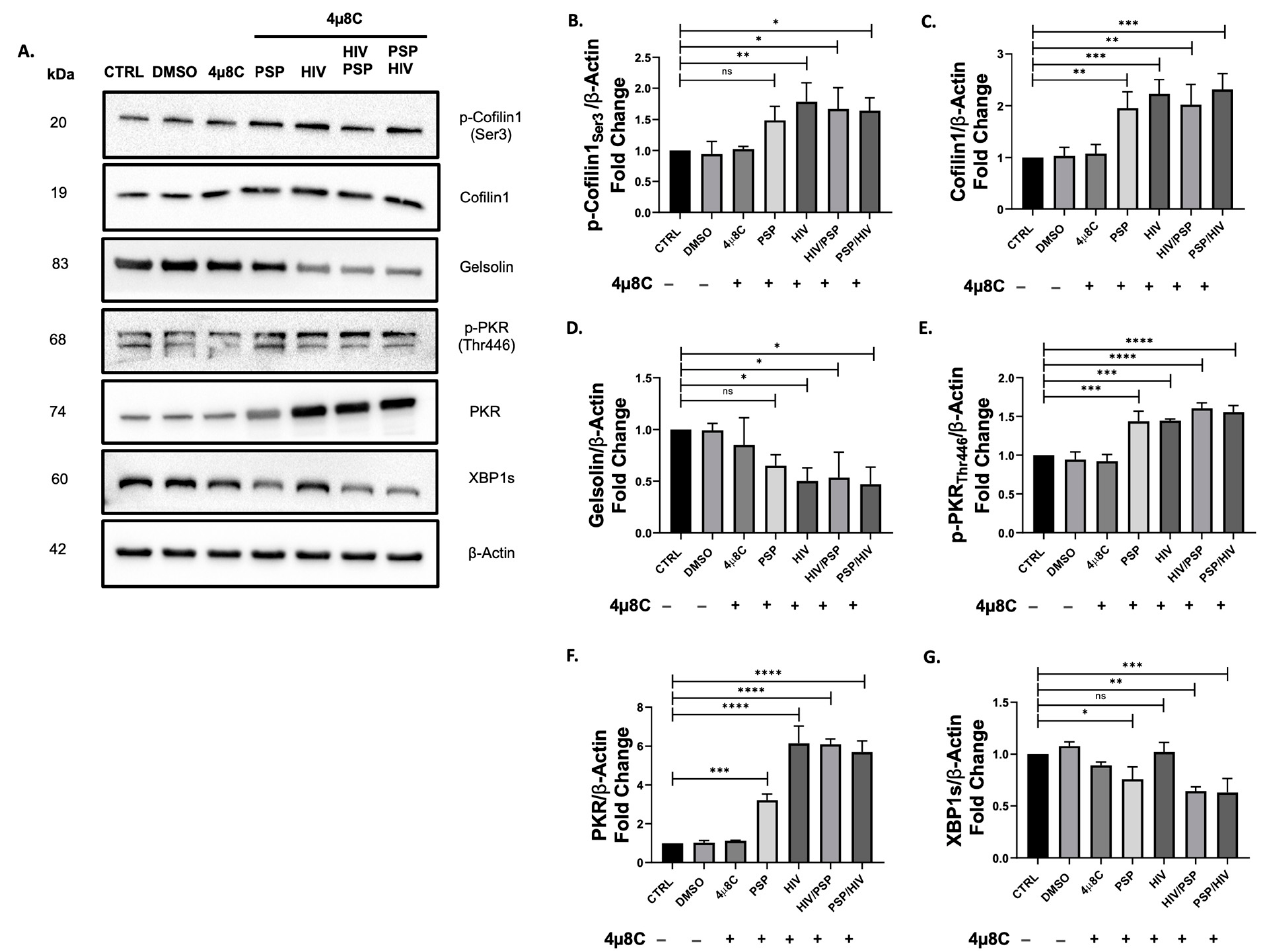
Figure 6. IRE1 α modulates downstream phosphorylation activity of PKR and cofilin-1. Endoribonuclease activity of IRE1 α was suppressed after 221.8 nM of 4µ8C inhibitor in THP1 monocytic cells with or without PSP treatment. ( A ) Representative Western blot data for the protein expression levels of cytoskeletal: ( B ) pCofilin1; ( C ) Cofilin1; ( D ) Gelsolin; IFN-IP: ( E ) p-PKR; ( F ) PKR and UPR: ( G ) XBP1s. β -Actin was used as a loading control and for normalization of data. Images were quantified using the ImageJ software (NIH, version 1.52a) by comparing the integrated density value with the control group. Mean ± SEM and significant difference (*), p ≤ 0.05, (**), p ≤ 0.01, (***), p ≤ 0.001, (****), p ≤ 0.0001 are shown and were determined using one-way ANOVA with Tukey multiple comparisons test, n = 3. All Western blot images can be found in Figure S2.